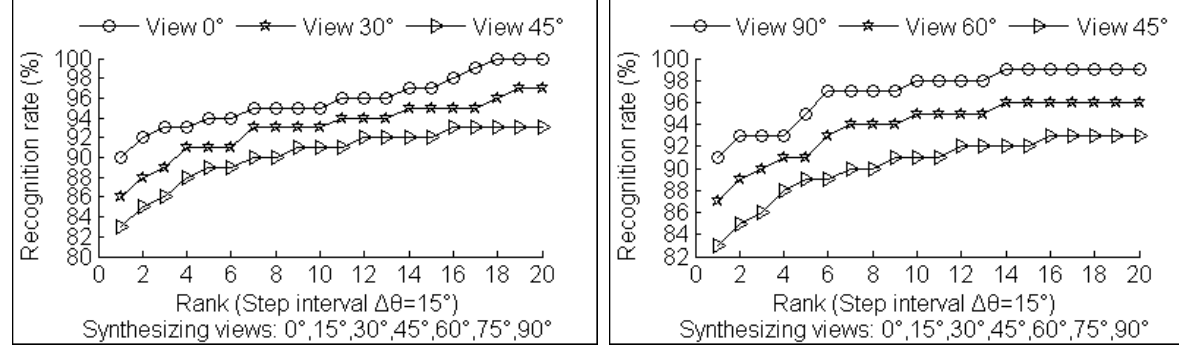
Figure 17. Recognition results with step interval ∆θ = 15°.